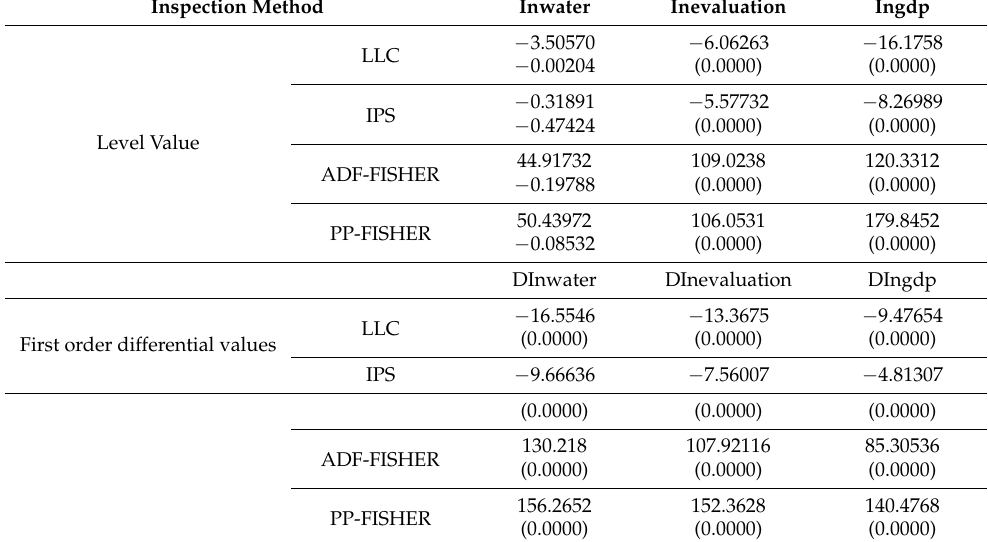
Table 2. Unit root test for panel data.